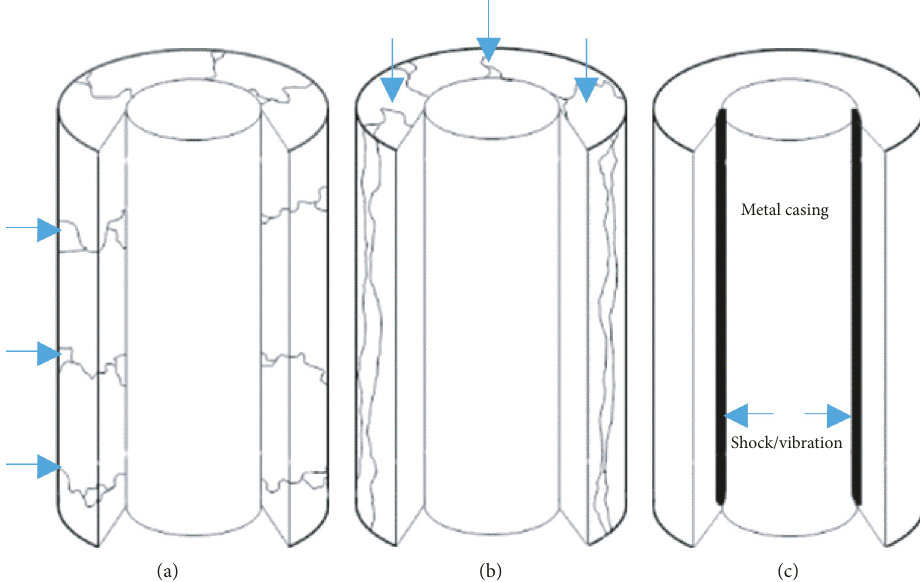
Figure 1: Several failure forms of cement rings: (a) transverse stresses failure; (b) longitudinal stress failure; (c)